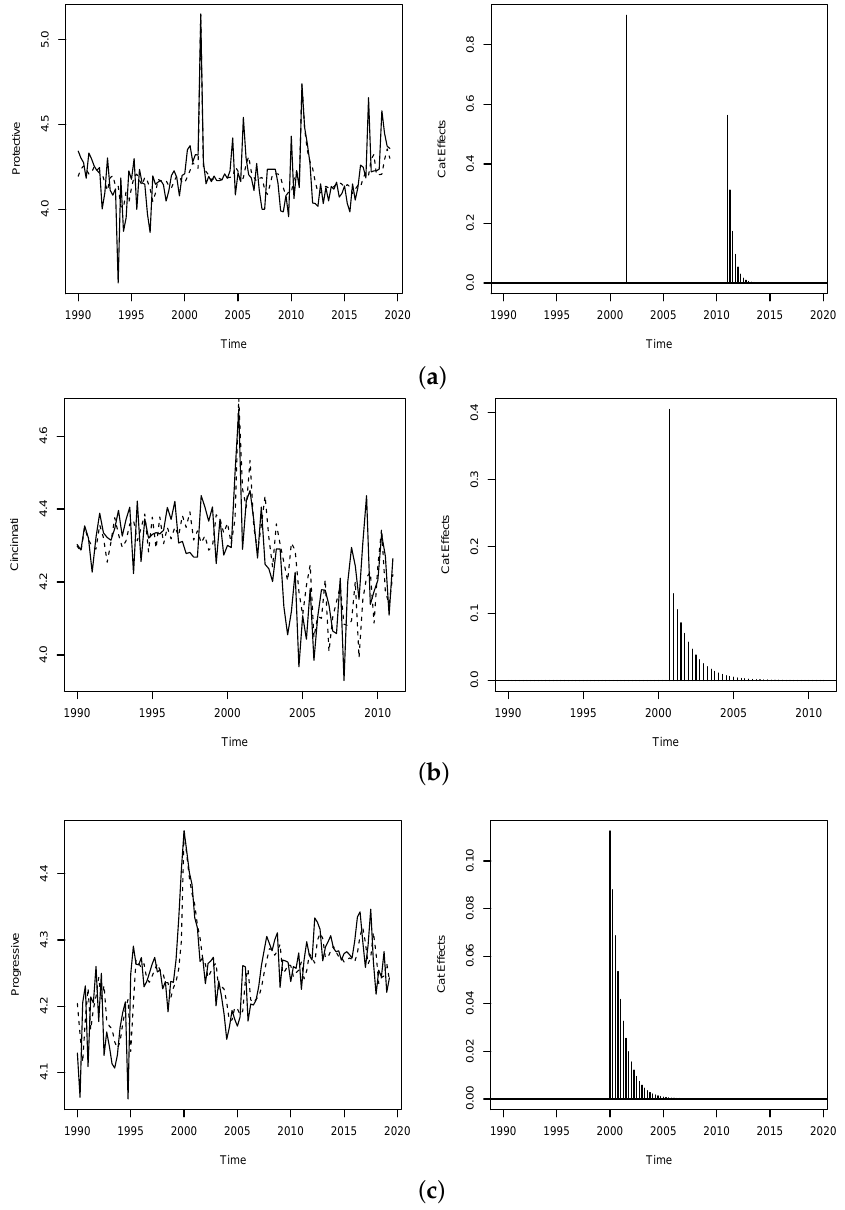
Figure 4. Fitted model ( left ) and estimated effects of catastrophes on the logarithmic loss ratios ( right ) for the companies ( a ) Protective, ( b ) Cincinnati, and ( c )